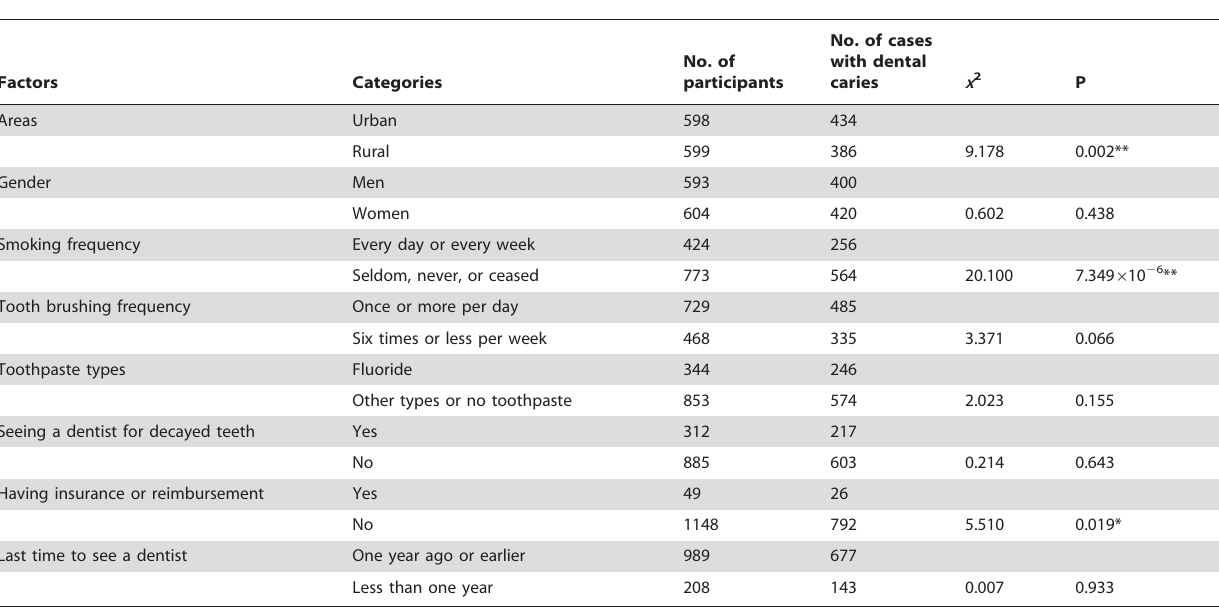
Table 2. Univariate analysis of potential risk factors in relation to prevalence of dental caries in an elderly population aged 65–74 years in northeast